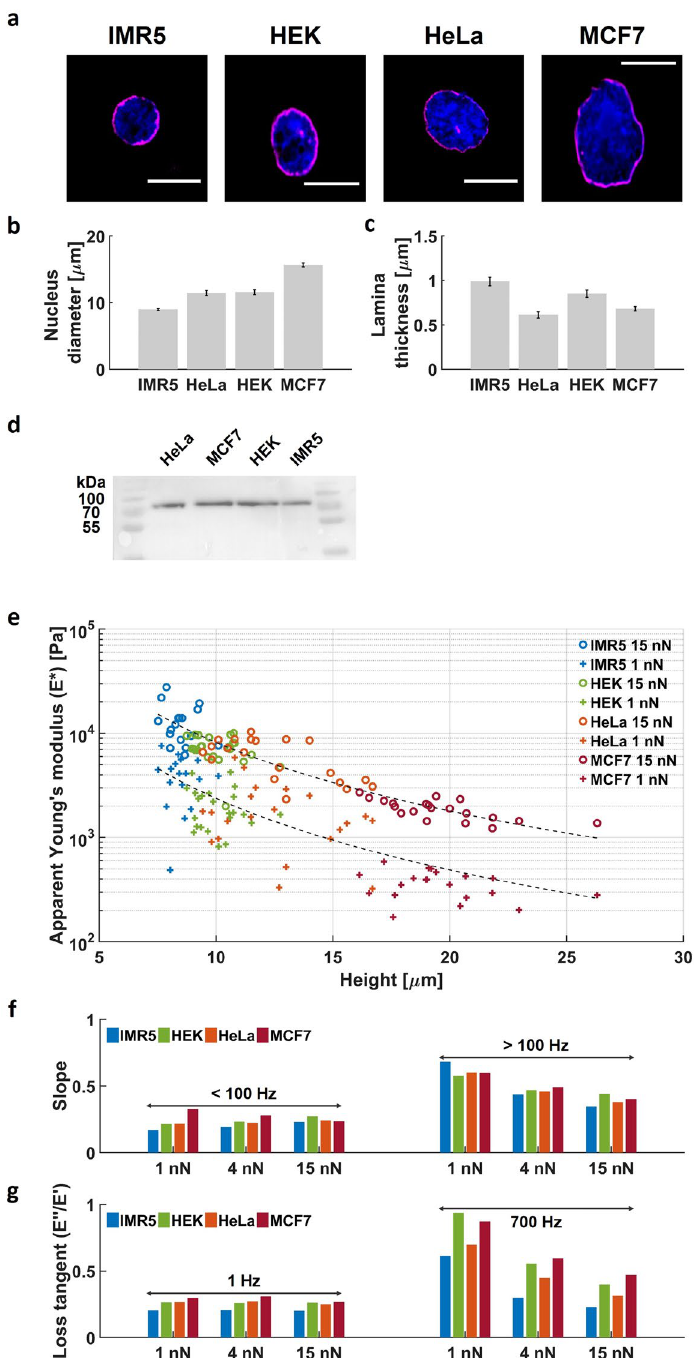
Figure 4. Comparing nuclei of different cell lines. ( a ) Example images from immunofluorescence staining against Lamin B with Hoechst staining for DNA in isolated IMR5, HEK293T, HeLa and MCF7 nuclei. Scale bar = 10 µ m. ( b ) Diameter of the isolated nuclei determined from the immunofluorescence staining. 8.9 ± 0.2 (n = 33), 11.4 ± 0.4 µ m (n = 18), 11.6 ± 0.4 µ m (n = 20) and 15.6 ± 0.3 µ m (n = 20), IMR5, HeLa, HEK293T and MCF7 respectively. Error bars are s.e.m. ( c ) The thickness of lamin B layer, estimated from the deconvoluted images. 0.99 ± 0.05 (n = 18), 0.62 ± 0.04 (n = 33), 0.85 ± 0.04 (n = 20) and 0.68 ± 0.02 (n = 20), IMR5, HeLa, HEK293T and MCF7 respectively. Error bars are s.e.m. ( d ) Western blot against lamin B in the nuclear extract from the cell lines used in the study. Samples were normalised to total protein content in the nuclear extract. ( e ) E * scales with the inverse of the nucleus size as shown by the fit ( ≡ α ⁎ E r with α = − . 2 21 and − 2.16 at 1 nN and 15 nN respectively). Nuclei appear always softer when subjected to smaller deformations. Individual responses can found in Supplementary Figure S1. The number of nuclei investigated per cell line is indicated in Table 1. ( f ) All nuclei show a slope α of the modulus vs. frequency response that only increased when probed at small deformations at high frequency. ( g ) All nuclei show a loss-tangent that only increased when probed at small deformations at high